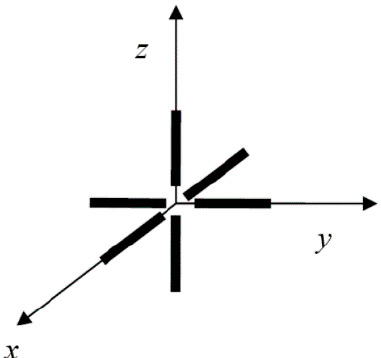
Figure 1. Structure of tripole vector antenna.